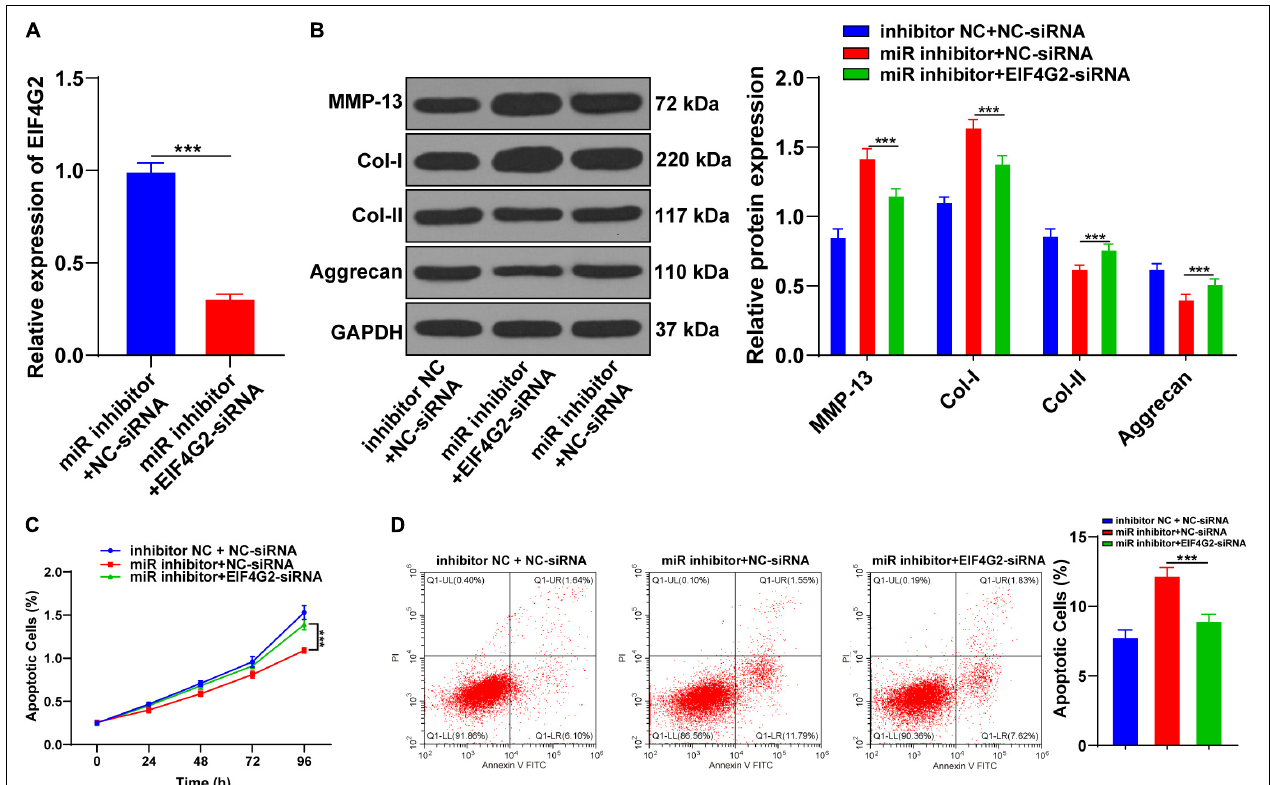
FIGURE 5 | Downregulation of EIF4G2 reversed the inhibitory effect of miR-101-3p inhibitor on ECM remodeling of NPCs. (A) EIF4G2-siRNA transfection efficiency was confirmed using the RT-qPCR; (B) MMP-13, Col-I, Col-II, and Aggrecan levels were detected using Western blotting; (C,D) viability and apoptosis of NPCs were detected using MTT assay and flow cytometry. The cell experiments were repeated three times independently. Data are presented as mean ± SD. Data in panel (A) were analyzed using the independent sample t -test; and data in panels (B–D) were analyzed using one-way ANOVA, followed by the Tukey’s multiple comparison test, *** p <